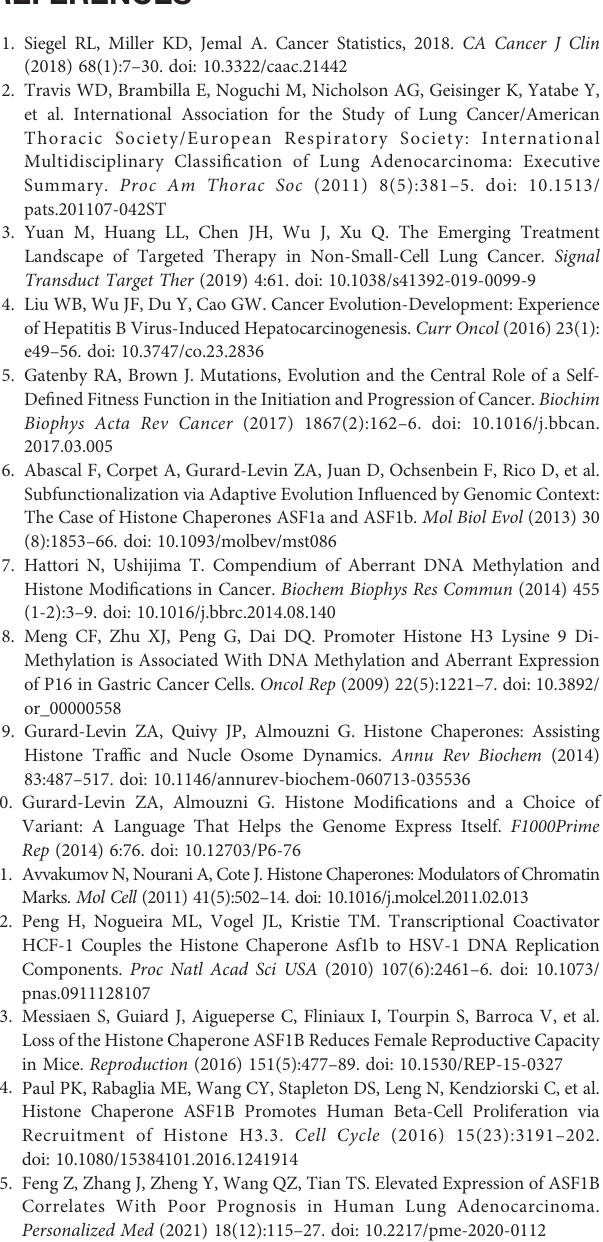
Supplementary Figure 6 | Western blot analysis of POLE3 in H1975 cells treated with knockdown-ASF1B and untreated controls cells. The density levels were quanti fi ed and represented as a bar graph. Supplementary Figure 7 | Association ASF1B with CKS1B, POLE3 and DHFR in pan-cancers and normal tissues. Supplementary Figure 8 | ASF1B is co-localized with CKS1B and POLE3 in cell nucleus. Supplementary Figure 9 | Immunoprecipitation Mass spectrometry of A549 cell line induced by overexpressed of ASF1B. Differentially expressed proteins in stable ASF1B-OE cells compared to negative control. (Volcano plot) Red presents up-